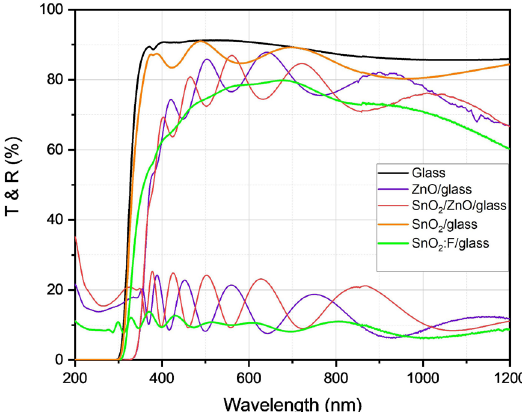
Figure 5. Transmittance and reflectance spectra in the UV-VIS of ZnO/glass, SnO